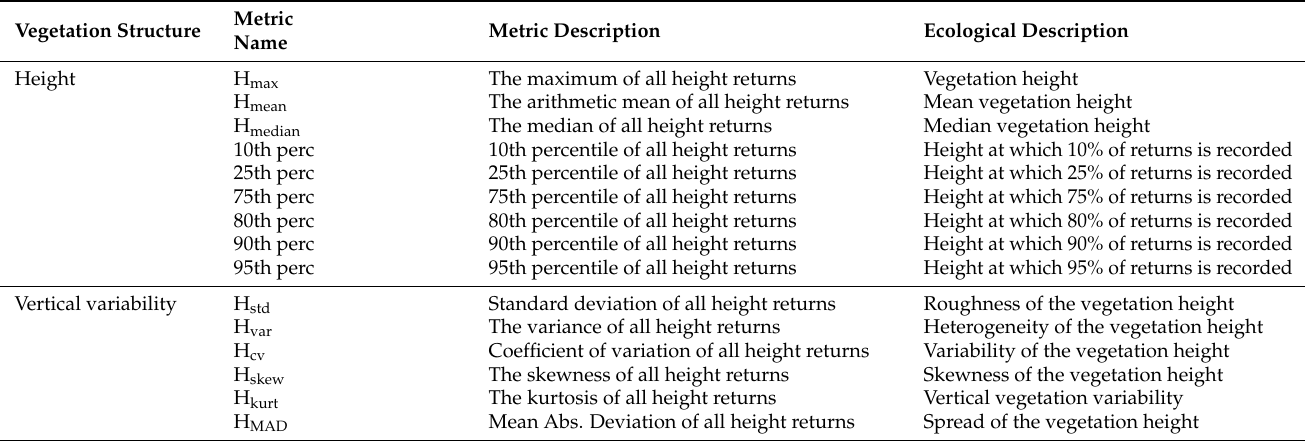
Table 1. LiDAR-derived metrics and their potential relevance for vegetation structure. Metrics that capture the height and vertical variability-related vegetation structure are calculated from the LiDAR point cloud for all sampling sites. Ecological relevance adapted from Bakx et al.